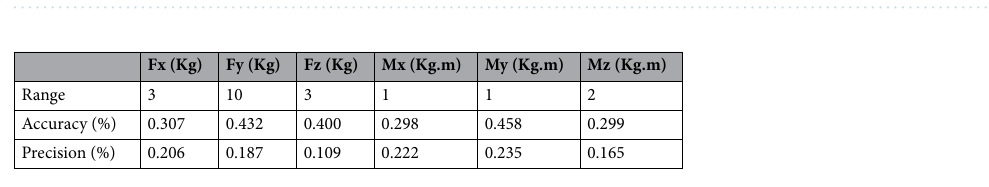
Figure 4. The force and moment measured system for six-component balance.